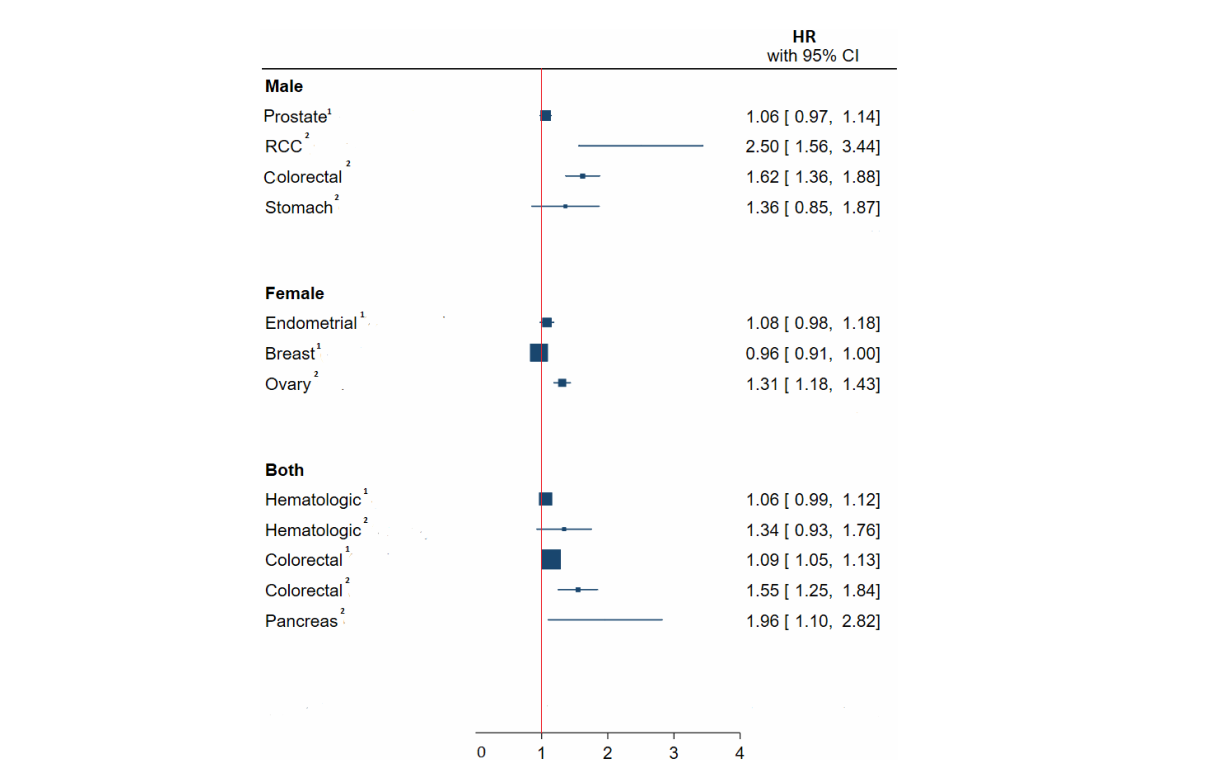
FIGURE 2 Meta-analysis of the association between obesity – related indices in children and adolescents with type of cancer in adulthood. HR, hazard ratio; CI, con fi dence interval; RCC, renal cell carcinoma. 1 , Continuous, one unit increase in BMI Z-score or SD; 2 , Binary, Highest measure/normal